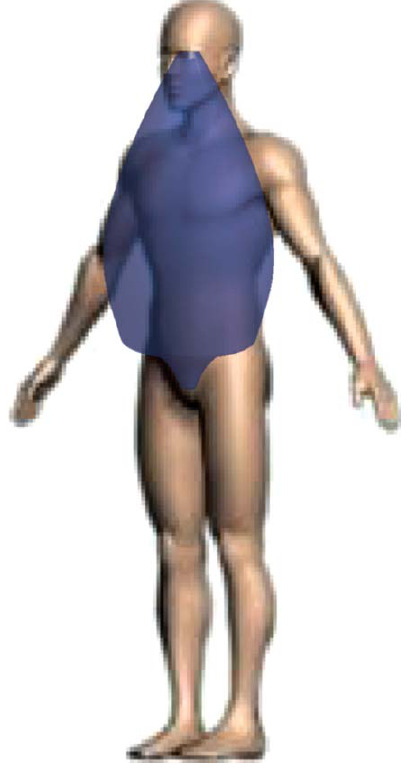
Fig. 17. Workspace with respect to